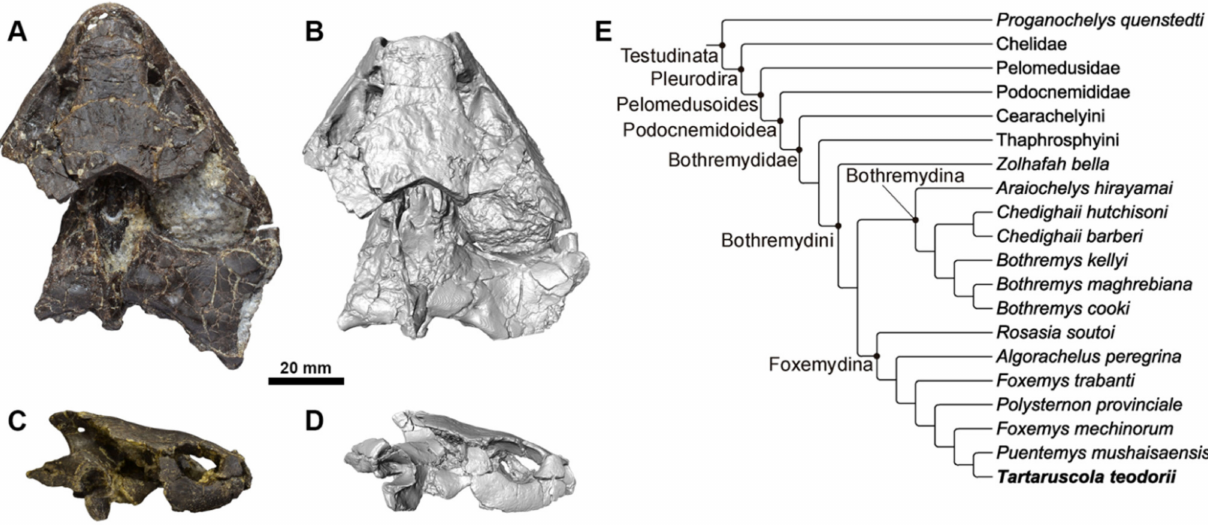
Figure 1. ( A , B ) Holotype (MNHN.F.SPP33) and ( C , D ) paratype (MNHN.F.SPP34) of Tartaruscola teodorii (Bothremydidae, Foxemydina), from the lower Ypresian (early Eocene) of Saint-Papoul (Aude, France), and phylogenetic position of the taxon. ( A – D ), photographs and ( A , C ) and virtual three-dimensional reconstructions of the skulls ( B , D ), in dorsal and ( A , B ), and right lateral ( C , D ) views. ( E ), Phylogenetic position of Tartaruscola teodorii in the single tree obtained through the phylogenetic analysis performed here, based on that proposed by P é rez-Garc í a